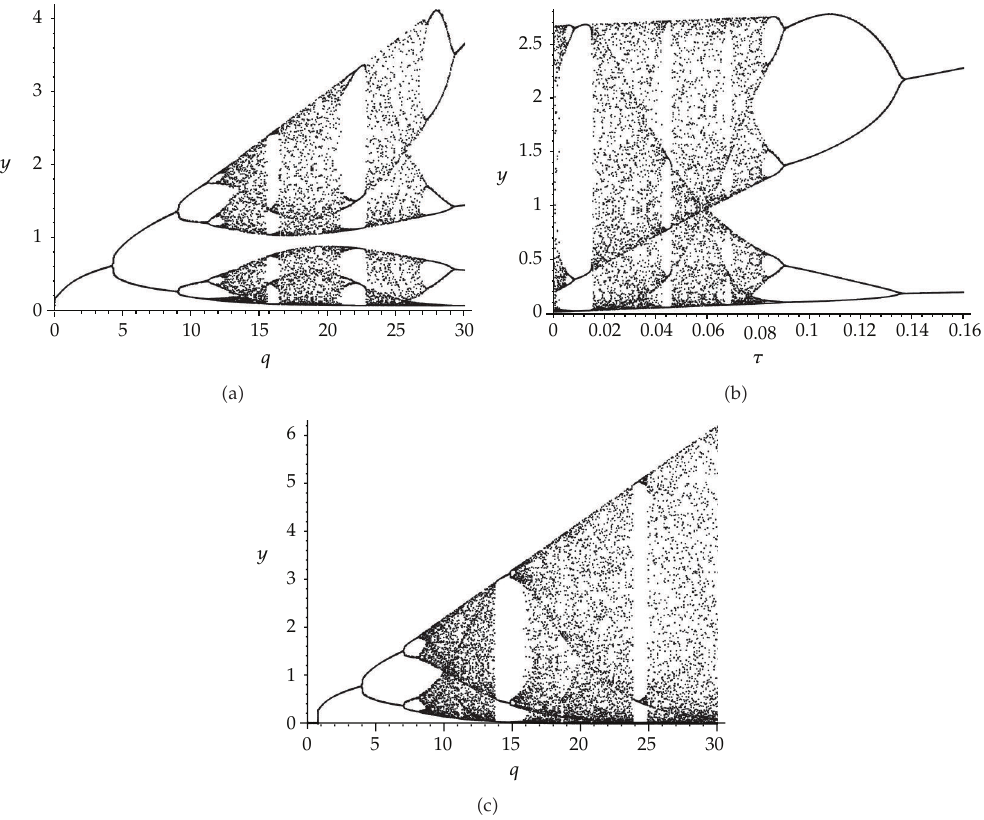
Figure 3: Bifurcation diagram of system (cid:7) 1.1 (cid:8) with initial conditions X (cid:7) 0 (cid:8) (cid:6) (cid:7) 0.02, 0.01 (cid:8) , h (cid:6) 0.21, p (cid:6) 0.8: (cid:7) a (cid:8) τ (cid:6) 0 . 065, (cid:7) b (cid:8) q (cid:6) 18, (cid:7) c (cid:8) τ (cid:6)